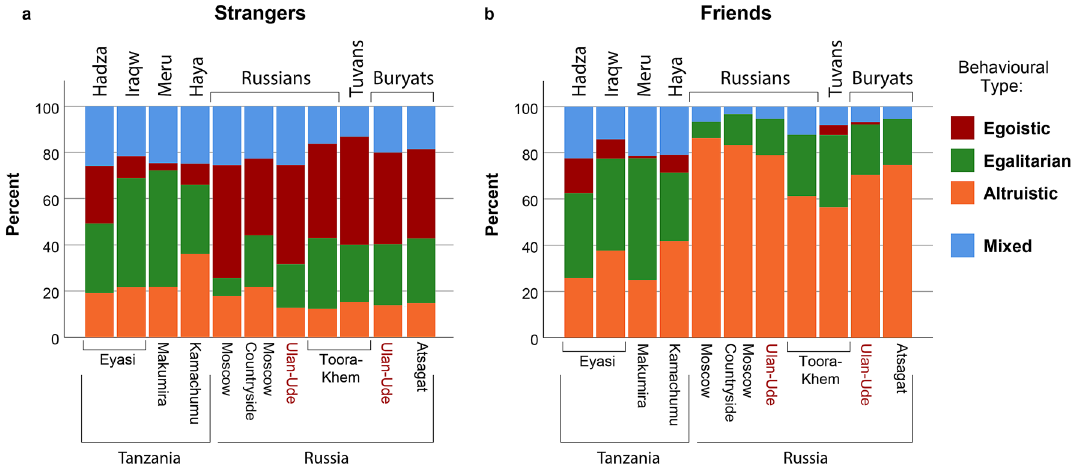
Figure 2. Distributions of behavioral types across ethnic groups with locations. Ethnic groups from Tanzania: Hadza, Iraqw, Meru, Haya; ethnic groups from Russia: Russians, Tuvans, Buryats. Rural locations: Eyasi, Makumira, Kamachumu, Toora-Khem, Atsagat; semi-rural location: Moscow countryside; urban locations: Moscow, Ulan-Ude. ( a ) Behavioral tendencies toward stranger partners; ( b ) behavioral tendencies toward